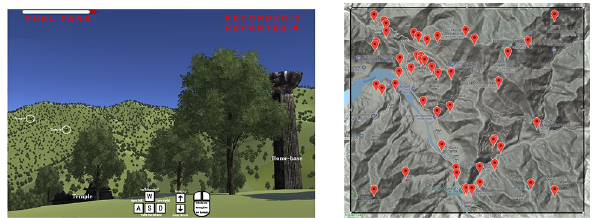
Figure 1. Game Environment. Left: An illustrative view of the virtual foraging game (key and mouse icons not shown during game play). Keys were used to move forward or backward (‘w’ or ‘s’), turn left or right (‘a’ or ‘d’), or tilt the view (‘up’ or ‘down’). The mouse was used to click on temples or the home-base. The ‘fuel tank’ showed the current energy remaining, ‘reported’ showed a running count of temples scored, and ‘recorded’ showed the current number of temples found but not yet reported to home-base (home-range condition only). Right: Distribution of selected temples in the Google Maps (Maps data ©2018) view of the Himalayan